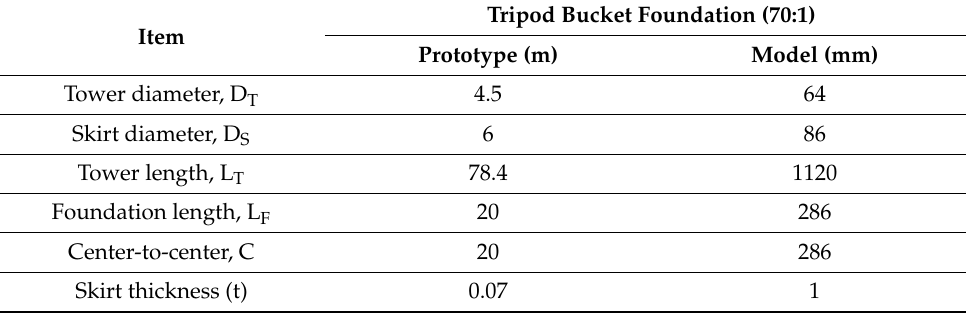
Table 5. Cyclic loading tests program.